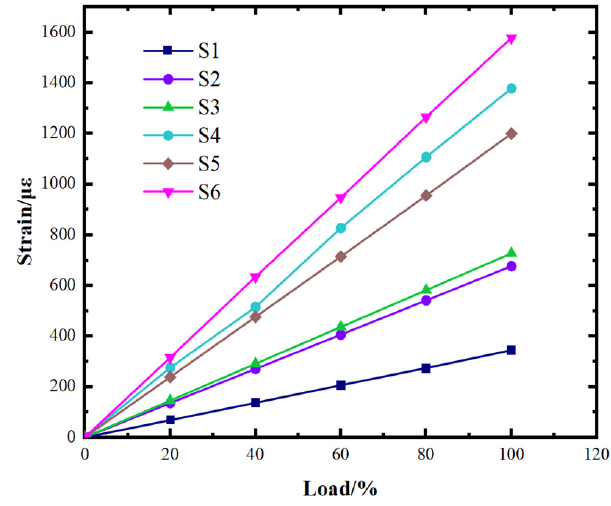
Figure 8. The strain curve under the test load.